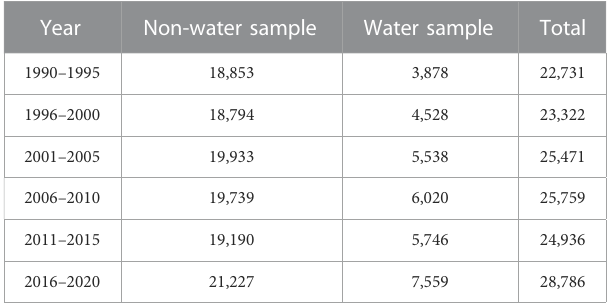
TABLE 3 Number of samples in each